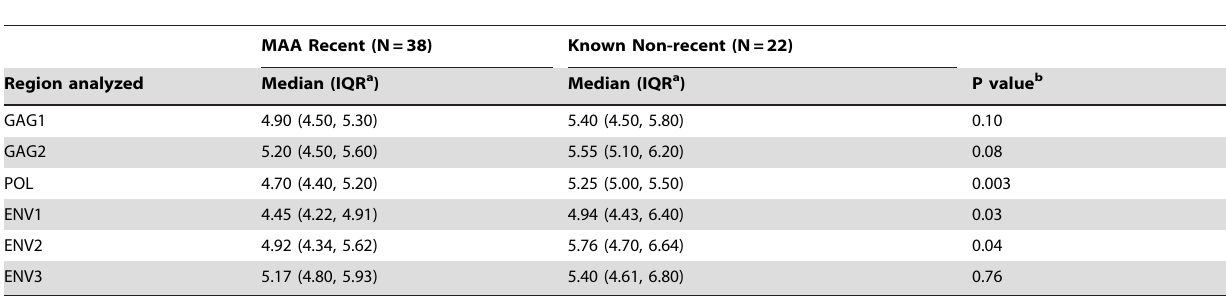
Table 4. Comparison of HIV diversity in women with MAA recent versus known non-recent HIV infection at follow-up.*